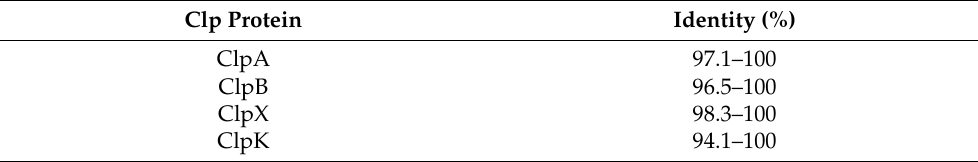
Table 2. Percentage identity of the various Clp proteins obtained through Clustal analysis. Clp